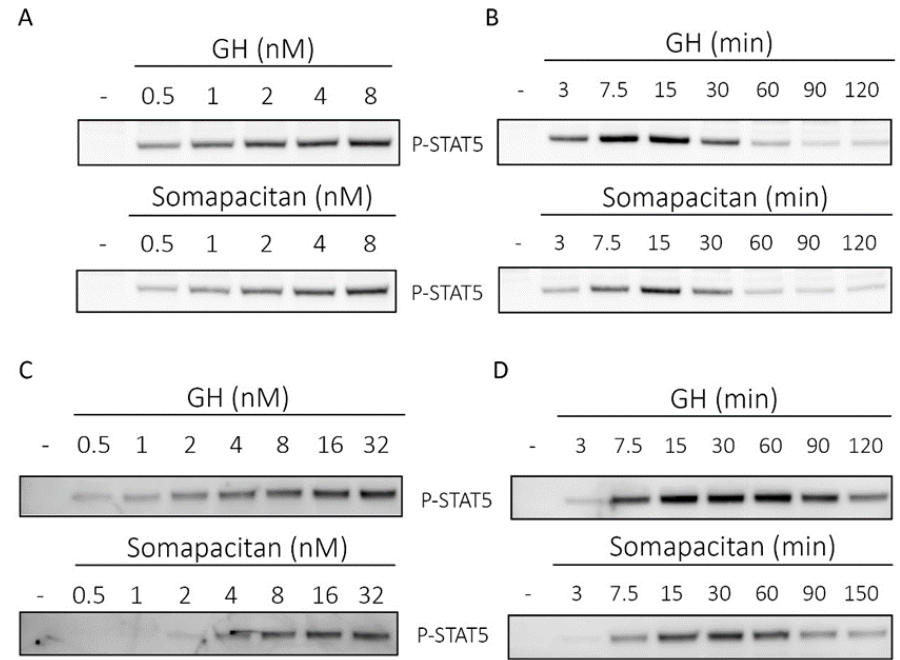
Figure 1. Direct comparison of growth hormone and somapacitan signaling kinetics. Primary rat hepatocytes ( A , B ) and human hepatoma cells ( C , D ) were treated with either GH or somapacitan. Concentration ( A , C ) or time-dependent ( B , D ) down-stream receptor activation was analyzed using SDS-PAGE and Western blotting with phosphorylated STAT5 (P-STAT5) antibody. ( A ) Primary rat hepatocytes were treated with a concentration gradient ranging from 0.5 to 8 nM of either GH or somapacitan for 15 min. ( B ) Primary rat hepatocytes were treated with 8 nM GH or somapacitan for a time range of 3 to 120 min. ( C ) Human hepatoma cells were treated with a concentration gradient ranging from 0.5 to 32 nM of either GH or somapacitan for 15 min. ( D ) Human hepatoma cells were treated with 8 nM of either GH or somapacitan and ligand-stimulation terminated at di ff erent time points ranging from 3 to 120 min. Equal amounts of protein loaded. Blots shown are one representative of three repeated